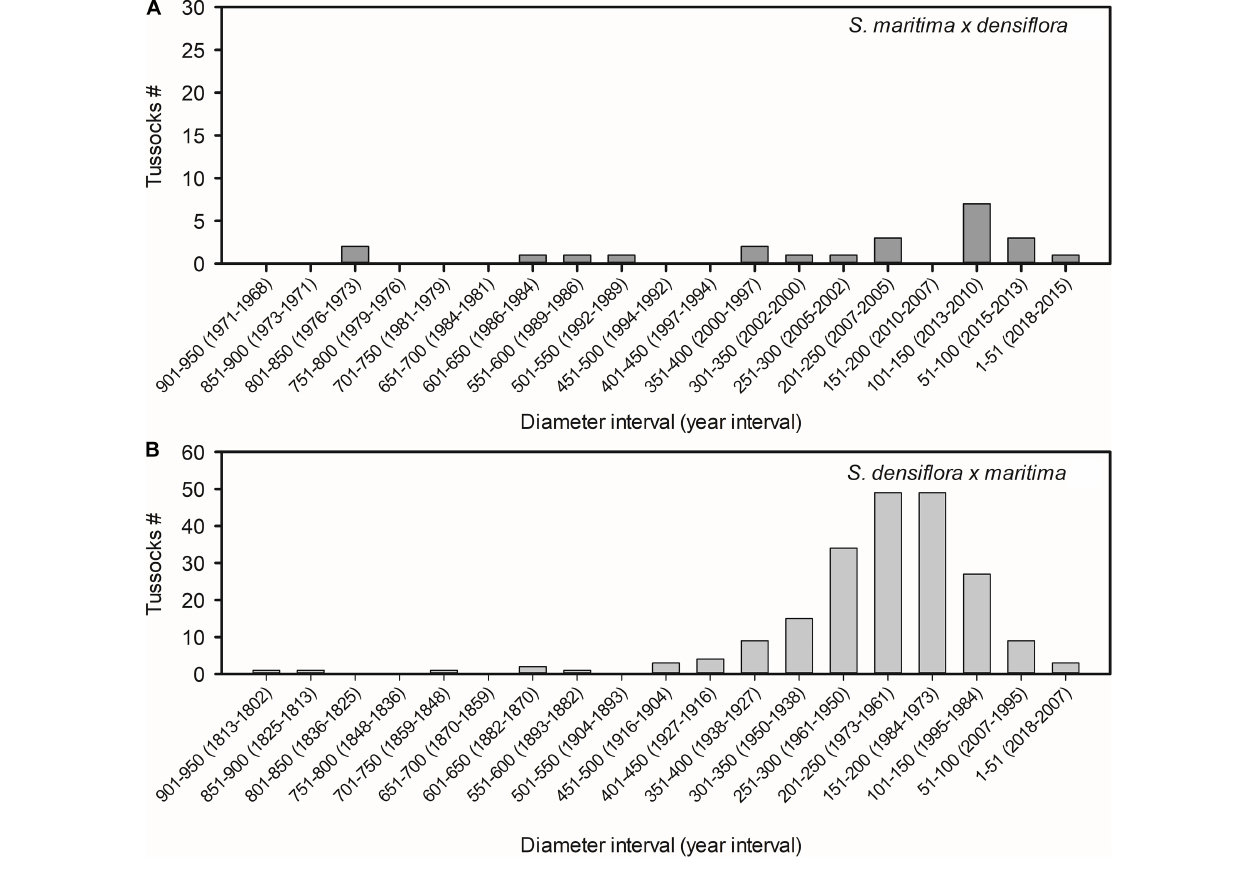
FIGURE 2 | Number of tussocks for different size classes (diameters in cm) of the hybrids (A) Spartina maritima × densiflora ( n = 22) and (B) S. densiflora × maritima ( n = 208) in the estuaries of the rivers Tinto-Odiel, Piedras, and Guadiana (Southwest Iberian Peninsula). The years of establishment estimated according to their lateral expansion rates by rhizomes are indicated in